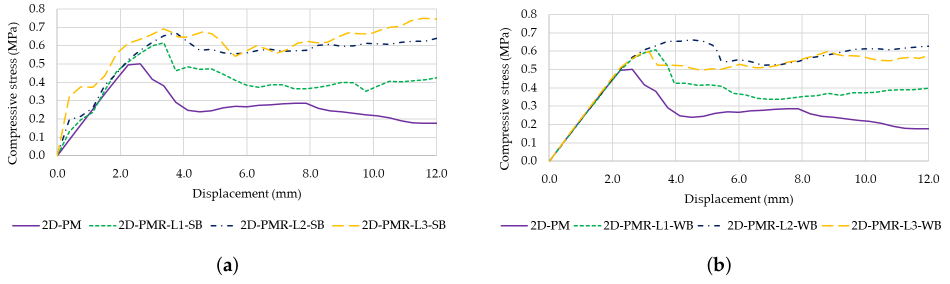
Figure 11. Numerical models: stress–displacement diagrams for the URM 2D-PM model and the 2D-PMR model for various reinforcement levels. ( a ) Strong bond; ( b ) Weak bond.